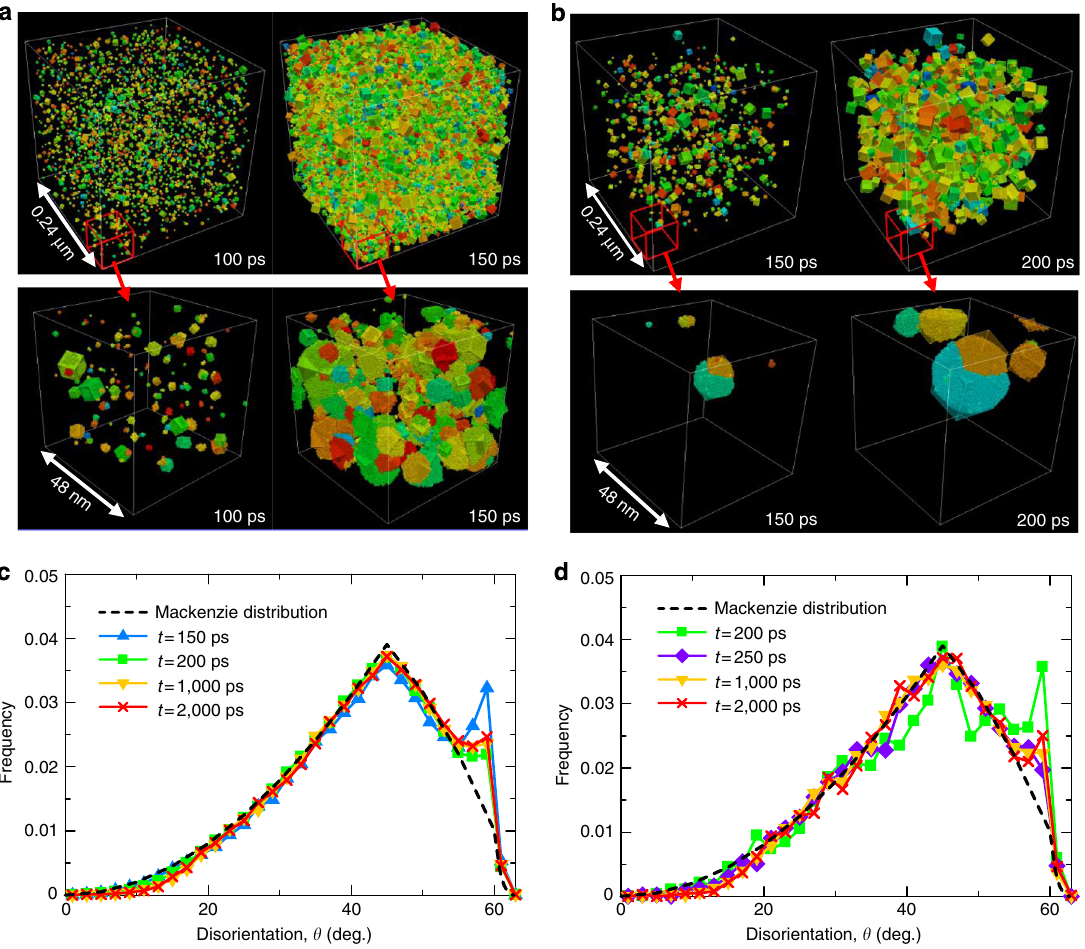
Fig. 4 Distribution of disorientation angle for all grains. a , b Spatial distribution of disorientation angle of each grain relative to the coordination axis for a 0.58 T m and b 0.67 T m . Cubes are located at the centres of grains. The volume and orientation of each cube are equivalent to the volume of the grain and the disorientation angle relative to the coordination axis, respectively. c , d Distributions of disorientation angle between neighbouring grains for c 0.58 T m and d 0.67 T m . The dashed line is the Mackenzie distribution function, representing a random Fig. 5a and the subgrain in Fig. 5b. The vertices of cubes indi- cating the disorientation angle of each grain relative to the coordination axis are labelled to clarify the positional relation- ships in the snapshots. The grain in Fig. 5c consists of subgrains A, B and C. It is con fi rmed that grain boundaries with a tilt angle of 109.47° exist along with a < 110 > tilt axis both between A and B and between B and C, which compose a coherent twin boundary. The grain in Fig. 5d consists of subgrains D and E. The grain boundary between subgrains D and E also has a tilt angle of 109.47° along with a < 110 > tilt axis.